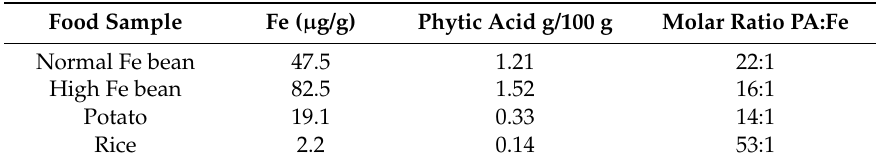
Table 1. Iron (Fe) and phytic acid (PA) content of beans for Experiments 1 and 2. The rice and potato samples were used in Experiments 3 and 4 1